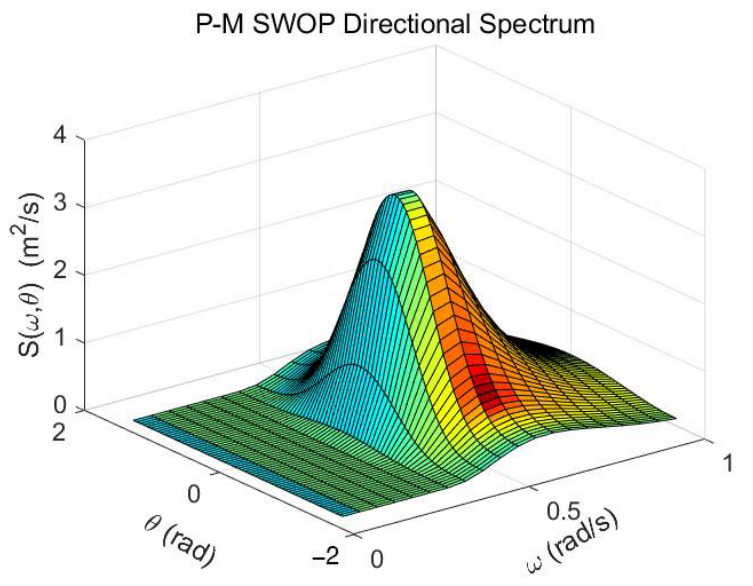
Figure 3. The 2D PM-SWOP spectrum with the wind speed of 12 m/s. θ is in the range [ − π /2, + π /2 ].